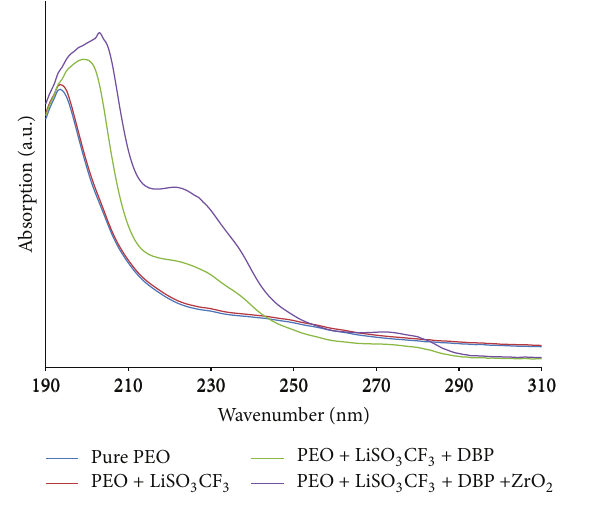
Figure 5: Optical absorption spectra for SPE for various wt.% of ZrO 2 nanofiller.